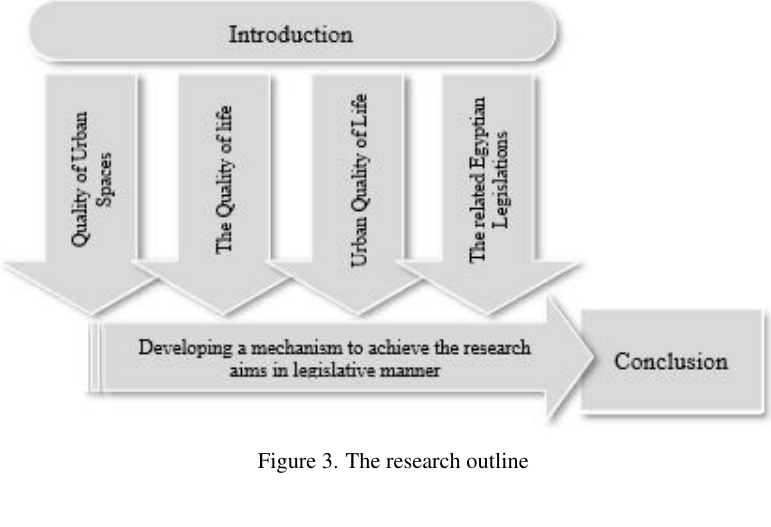
Figure 3. The research